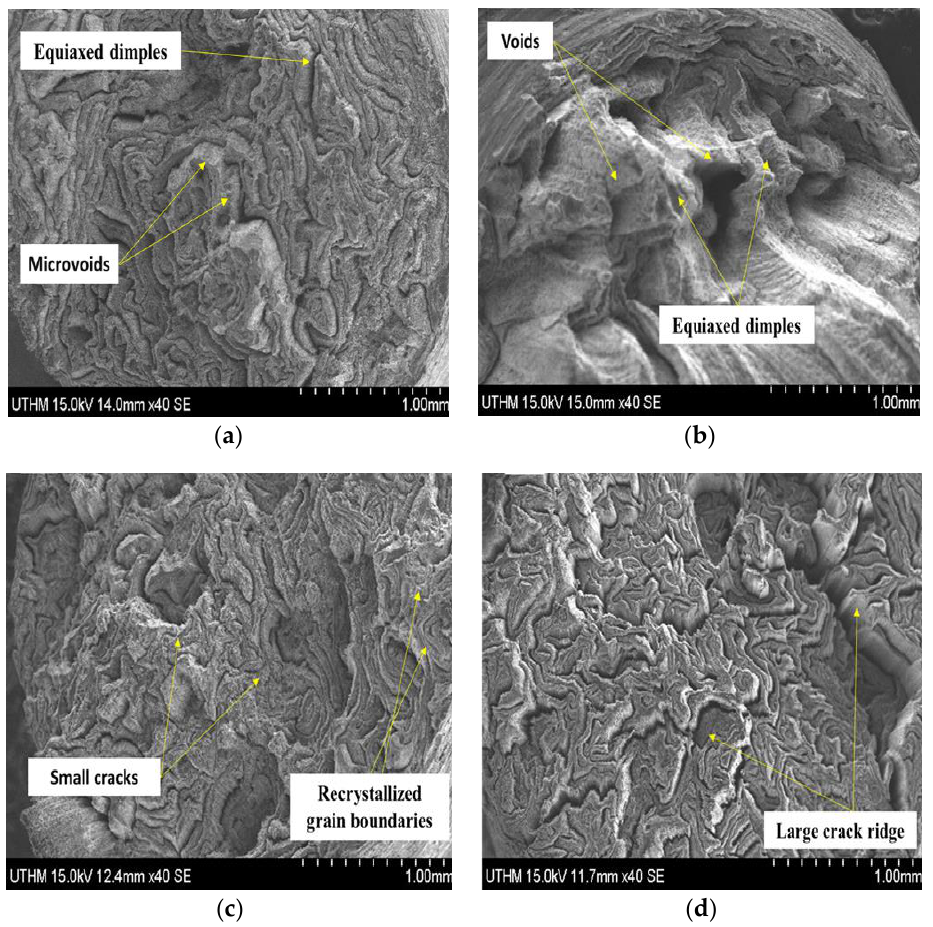
Figure 18. SEM micrographs of fracture surface of the tensile sample ( a ) 2 vol% CuO, 550 °C and 3 h. ( b ) 2 vol% SiO 2 , 550 °C and 3 h. ( c ) 1 Vol% SiO 2 , 1 vol% CuO, 550 °C and 3 h. ( d ) 1 vol% SiO 2 , 1 vol% CuO, 450 °C and 1 h.